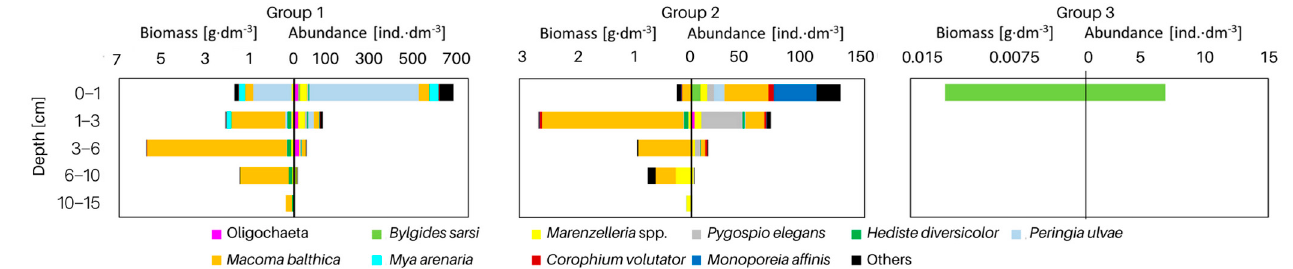
Figure 4. Vertical distribution of macrofaunal taxa deep into the sediment in each group of the sites shown in Figure 3. The scale of abundance and biomass differs for individual groups.